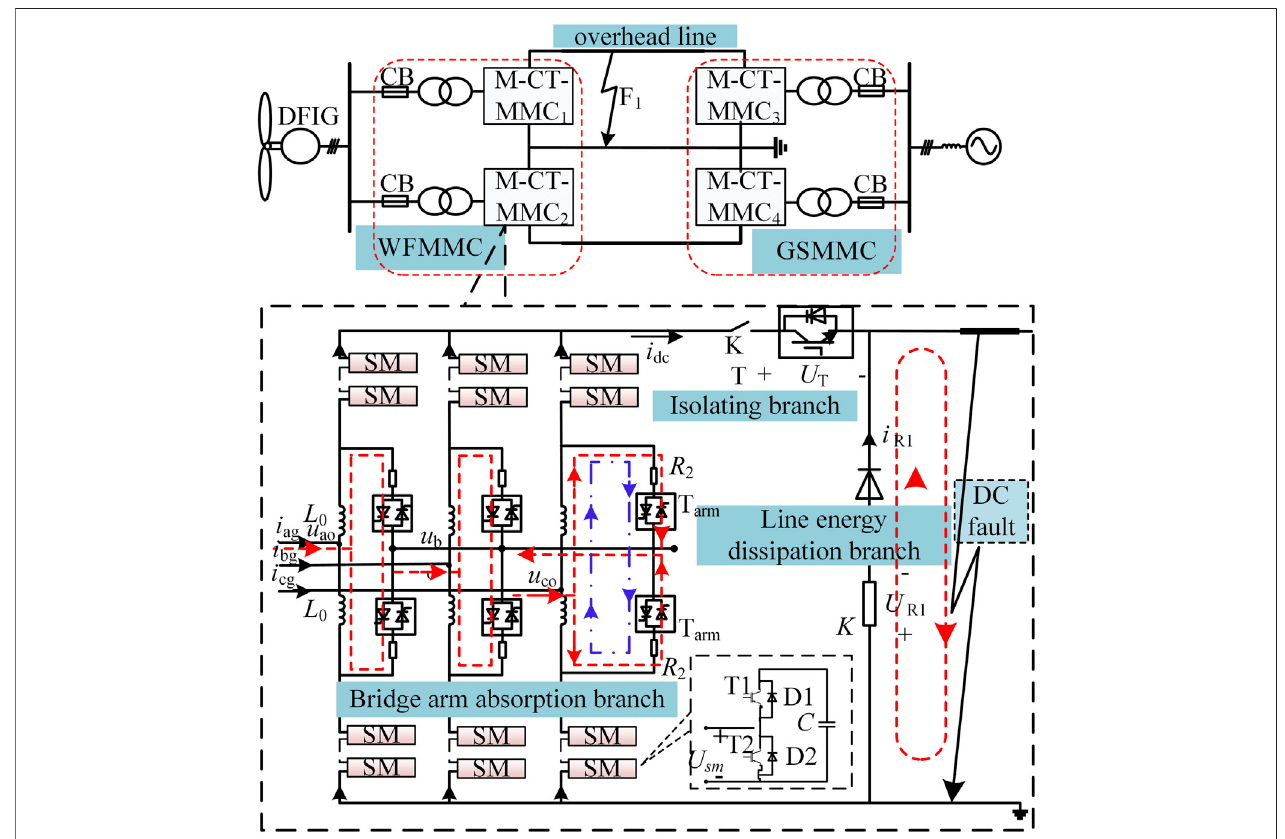
FIGURE 1 | DC system with wind power integration and M-CT-MMC